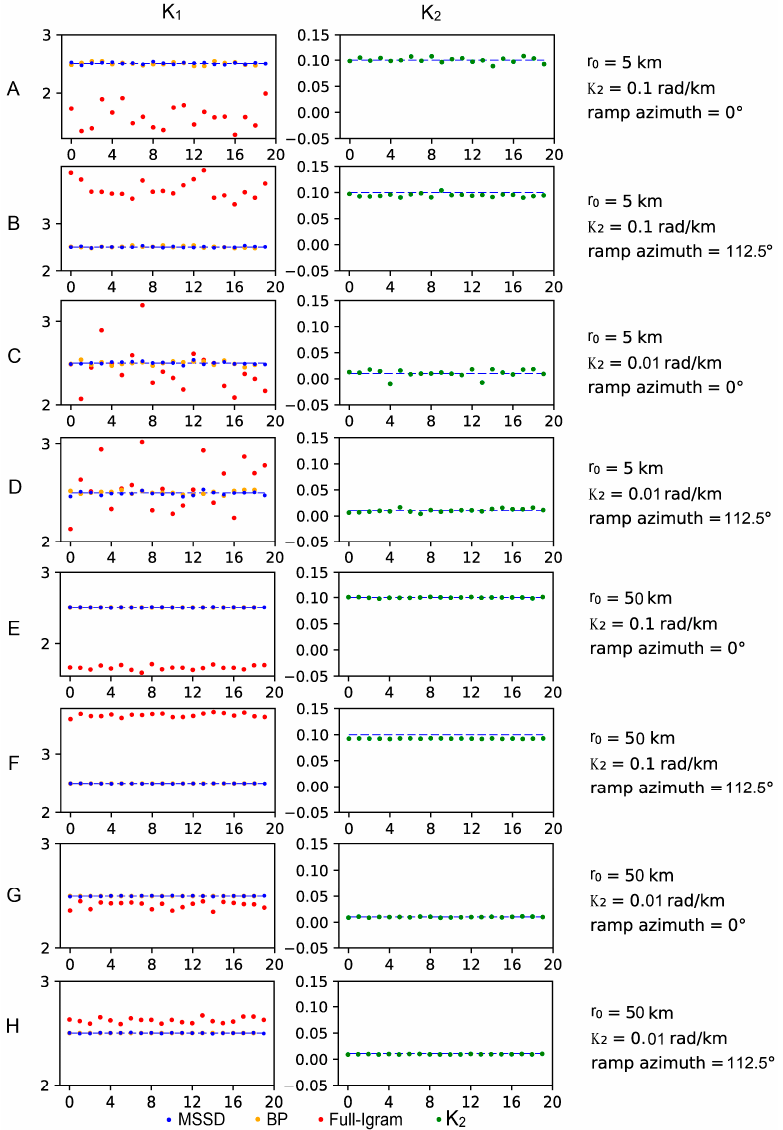
Figure 5. Comparison of the transfer functions estimated by using full interferogram–topography correlation, BP, MSSD, and the K 2 estimated by our method. There are 20 realizations of synthetic interferograms in each plot, with different turbulence signals, amplitudes, and ramp directions. The input K 1 is 2.5 rad/km (first column, blue dashed lines). The input K 2 is 0.1 rad/km ( A , B , E , F ) and 0.01 rad/km ( C , D , G , H ) respectively (second column, blue dashed